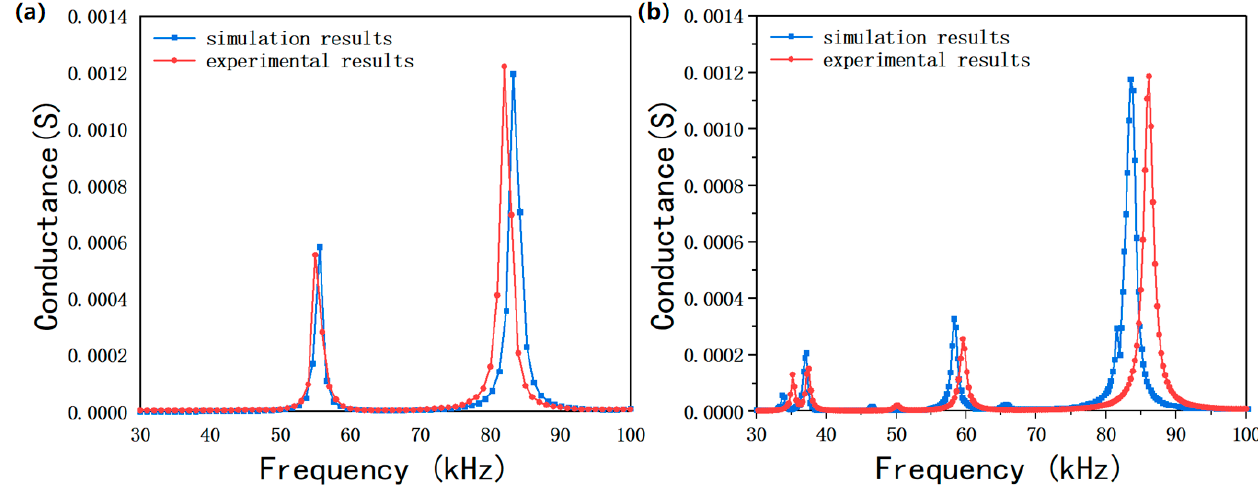
Figure 12. Comparison between finite element simulation and experimental results of conductance curves. ( a ) Four bonded ceramic plates; ( b ) piezoelectric oscillator.